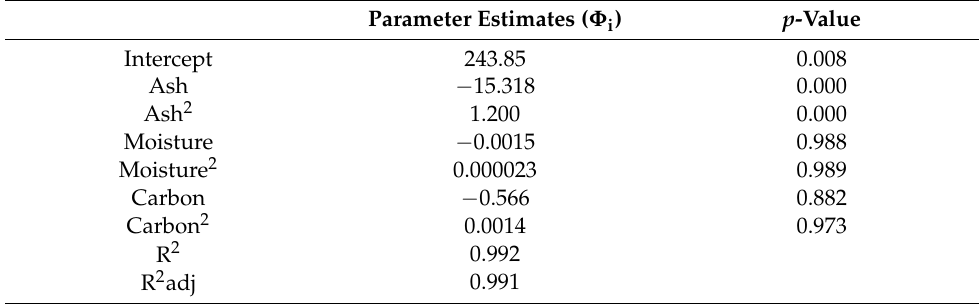
Table 5. Parameter estimates for quadratic response function for biofuel yield (liters) considering